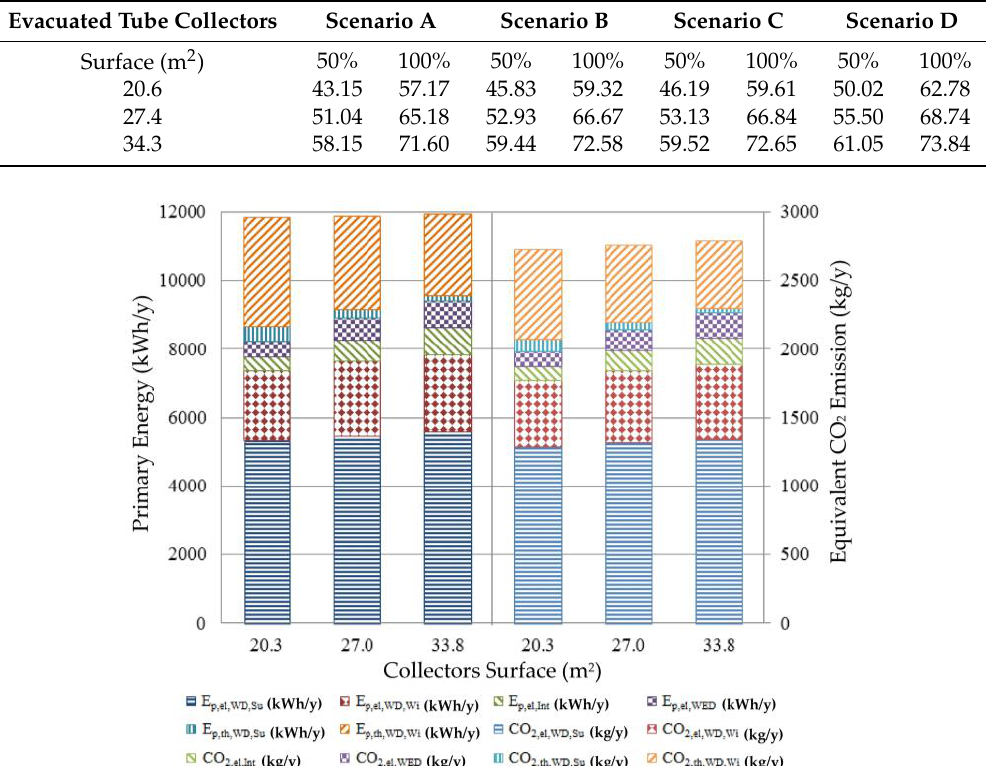
Figure 12. Annual primary energy consumption and equivalent CO 2 emission for the plant with pre-CC (Scenario D), flat-plate collectors, 40° tilt angle and 0% of solar thermal energy surplus used.